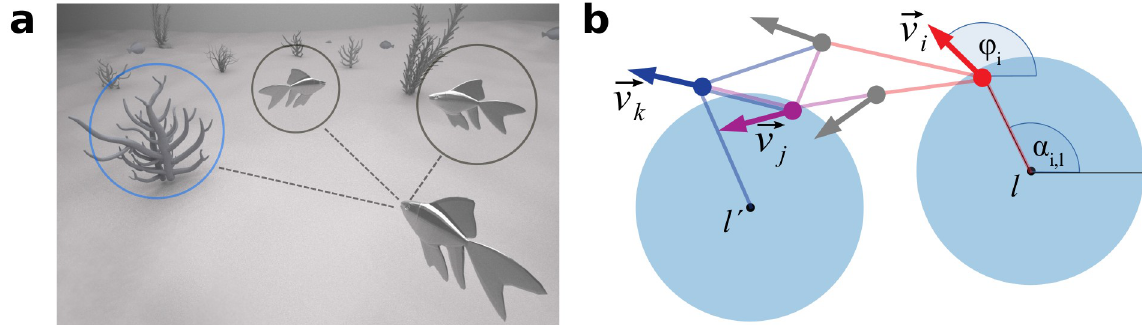
Fig 1. Attention trade-off in collective behavior. a : Schematic visualization of attention trade-off in collective behavior in complex environments. The focal individual can only pay attention to k = 3 nearest objects—other agents or non-social environmental features— simultaneously. b : Visualization of different situations that may occur in the model. The arrows indicate the velocity vectors ~ v of the different agents. The small black circles indicate the location of danger sites l and l 0 with their repulsion zones shown in blue. Agent i (red) reacts to the danger site (DS) l as two conditions are met simultaneously: DS l is in i ’s kNO, and agent i is also within the corresponding repulsion zone. Agent j (magenta) does not react to DS l 0 since it’s attention slot is already filled with three other agents (one blue and two gray). Agent k (blue) perceives DS l 0 but does not react to it, because it is outside of the repulsion zone. It only reacts to two other neighbors (gray and magenta) and aligns with them.